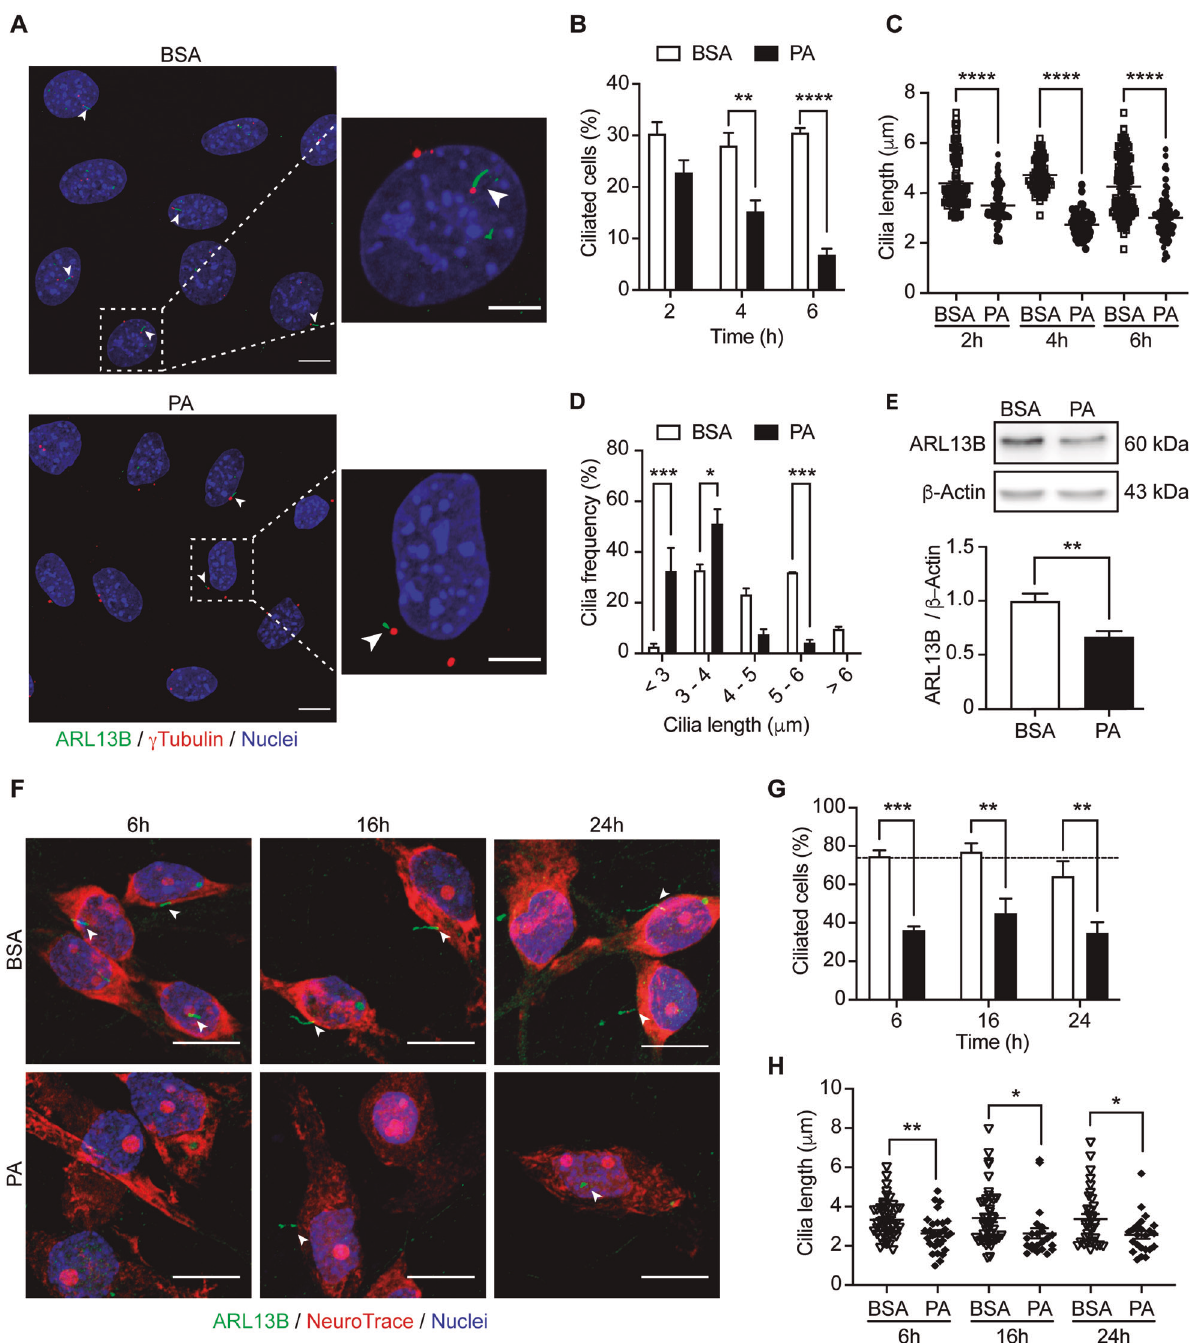
Fig. 2 Palmitic acid reduces the percentage of ciliated cells and primary cilium length in hypothalamic neurons. A Representative confocal images of N43/5 hypothalamic neuronal cells treated with BSA (vehicle) or palmitic acid (PA, 100 μ M) during 6 h, stained against ARL13B (ADP- ribosylation factor-like protein 13B, cilia axoneme) and γ -tubulin (cilia basal body). Scale bar: 10 µm. Inserts show a magni fi cation of one cell within the dotted square. Insert scale bar: 5 µm. Arrowheads indicate the primary cilium. Quanti fi cation of B percentage of ciliated cells, C cilia length, and D cilia length distribution of N43/5 hypothalamic cells treated with BSA (vehicle) or palmitic acid (PA) during 2 h, 4 h, and 6 h and stained against ARL13B. E Representative western blot of ARL13B proteins levels in N43/5 cell lysates, incubated with BSA or PA (100 μ M) for 6 h with the respective quanti fi cation. F Representative confocal images of primary hypothalamic neurons treated with BSA or PA (100 μ M) for 6 h, 16 h, and 24 h, stained against ARL13B and with the neuronal marker NeuroTrace, with their respective quanti fi cations ( G , H ). Arrowheads indicate the primary cilium. Scale bar: 10 µm. Nuclei were stained with Hoechst (blue). Data are presented as mean ± SEM. Statistical differences were evaluated by using: B , D , G Two-way ANOVA followed by post hoc Sidak multiple comparison test; C one-way ANOVA, post hoc Tukey multiple comparison test; E , H unpaired two-tailed Student t -test. * p < 0.05, ** p < 0.01, *** p < 0.001, **** p < 0.0001. n = 3.